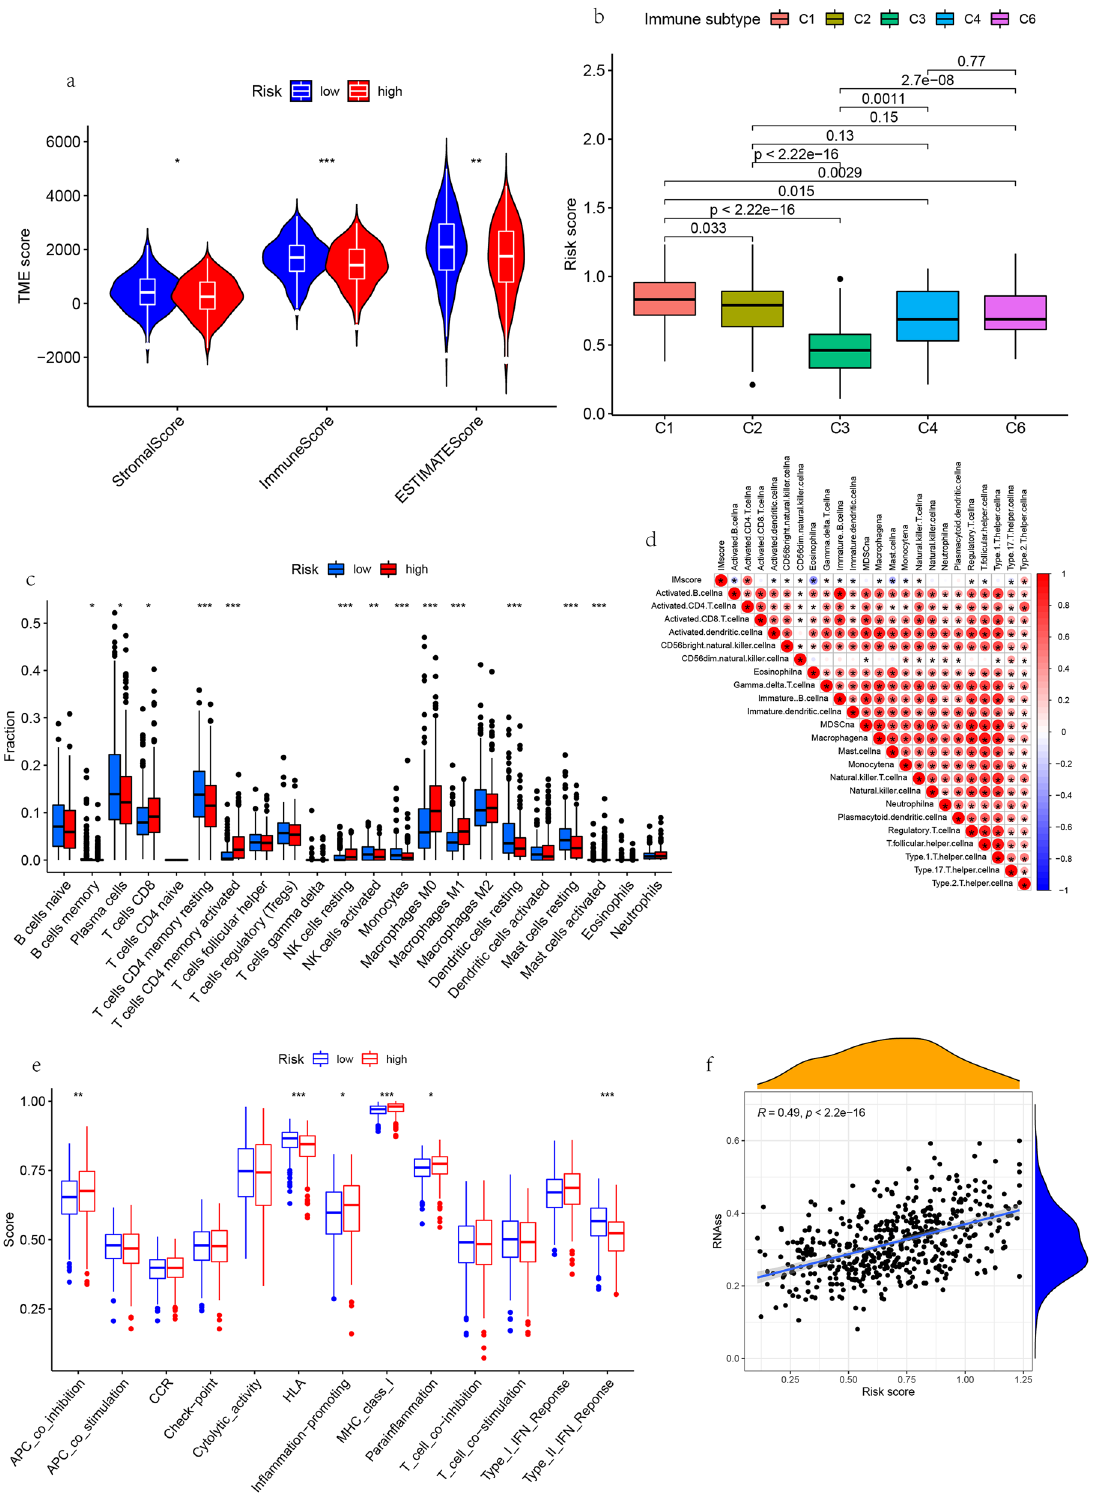
Figure 10. Relationship between tumor immune cell infiltration and risk score. ( a ) Relationship between tumor microenvironment and immune risk characteristics. ( b ) The relationship between risk score and immune typing. ( c ) Association between tumor infiltrating immune cells and immune risk characteristics. ( d ) Correlation analysis of immune cells. ( e ) Analysis of immune related function among different risk groups in The Cancer Genome Atlas (TCGA) cohort. The boxplot shows the scores of 13 immune related functions. The pvalue is displayed as: * P < 0.05,** P < 0.01,*** P < 0.001. ( f ) Correlation between stem cells and risk